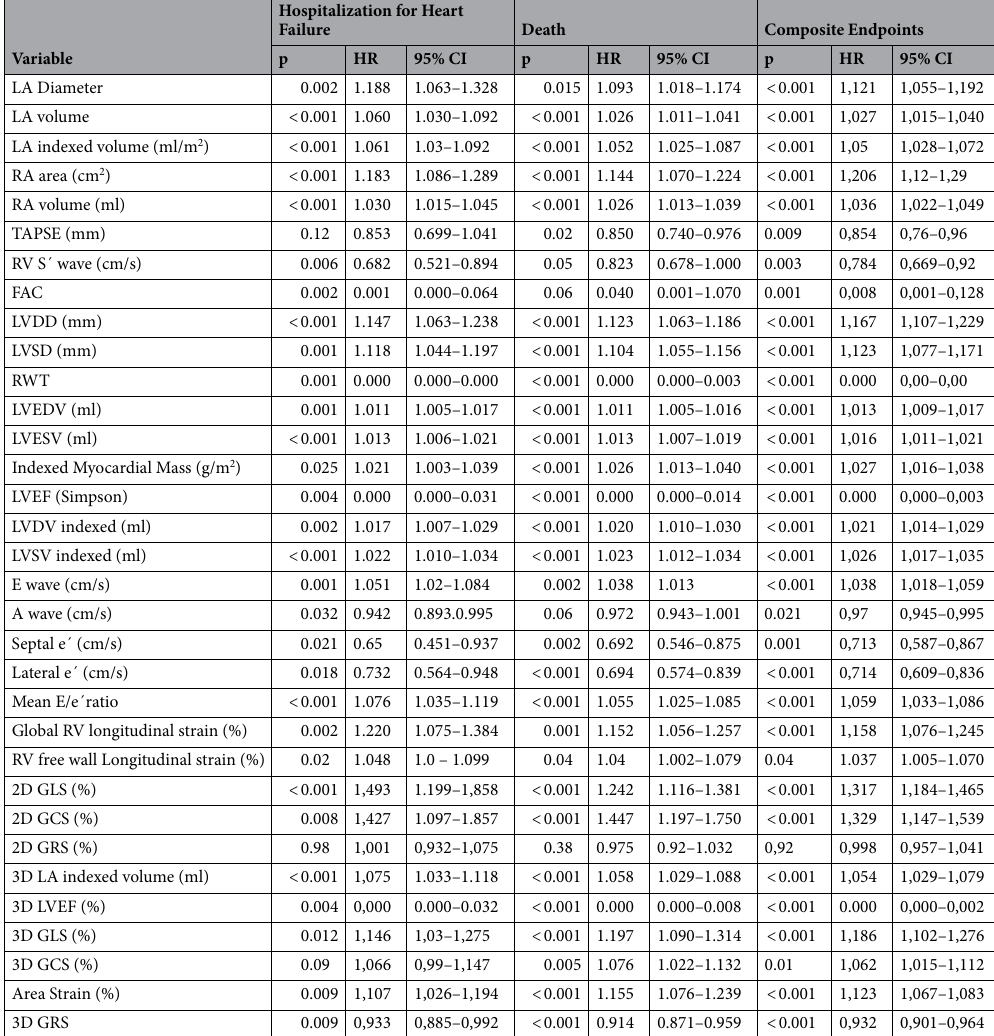
Table 5. Predictors of Composite Endpoints, overall mortality and hospitalization for heart failure in patients with Chagas Disease. HR hazard ratio, CI confidence interval. *Values of p < 0.05 indicate statistical significance. FAC fractional area change, LA left atrium, LV left ventricle, LVDD left ventricular diastolic diameter, LVDV left ventricular diastolic volume, LVEDV left ventricular end-diastolic volume, LVEDV left ventricular end-systolic volume, LVEF left ventricular ejection fraction, LVSD left ventricular systolic diameter, LVDV left ventricular diastolic diameter, RA right atrium, RV right ventricle, RWT relative wall thickness, TAPSE tricuspid annular plane systolic